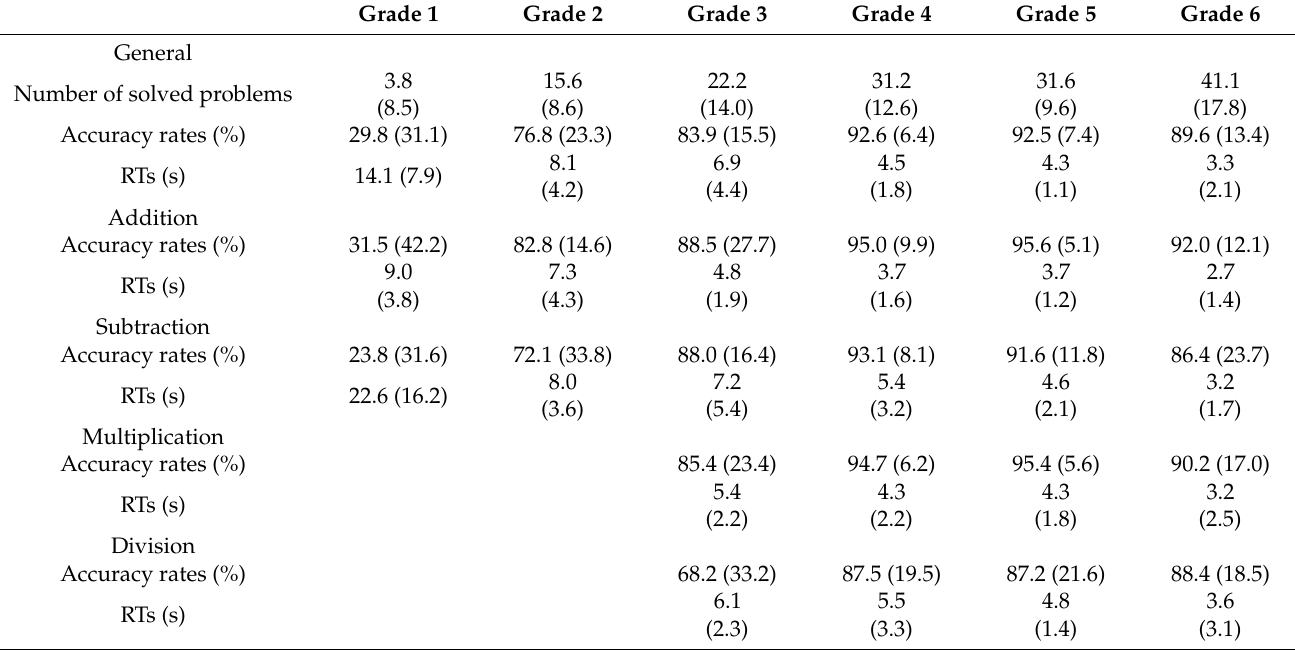
Table 2. Descriptive statistics for different grades and operations in the BGU-MF test.